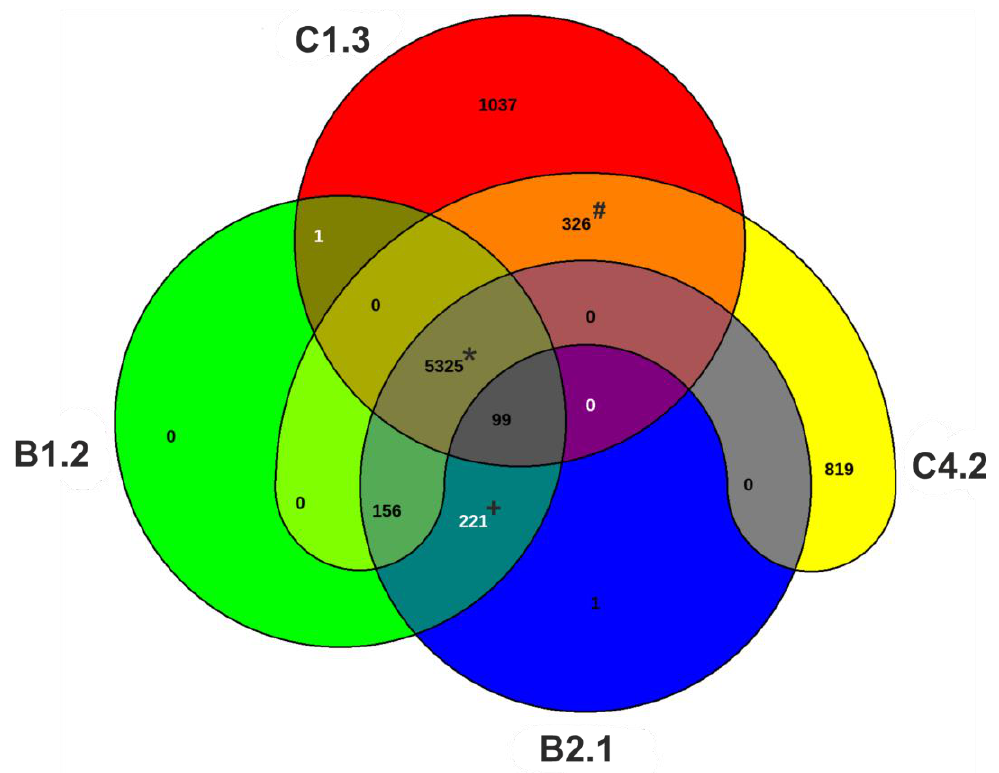
Figure 4. Venn diagram displaying the pan-genome of the P. aeruginosa isolates. The four isolates have a core genome with 5325 CDS (asterisks). The B isolates shared 221 orthologous CDS (cross). Orthologous shared CDS among the C isolates are 326 genes (hashtag). Venn diagram was produced using EDGAR 3.0.